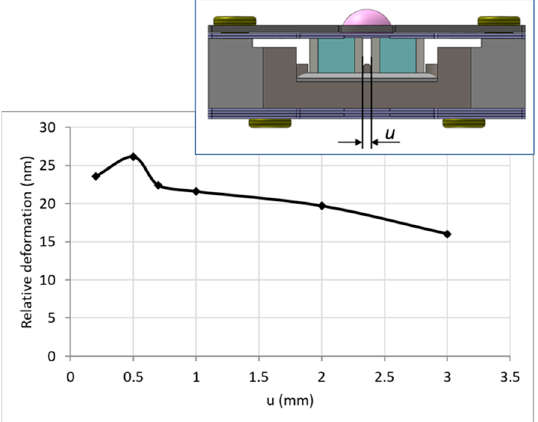
Figure 3. The relative deformation of the friction coupler is at a maximum when the distance between the actuators is 0.5 mm.